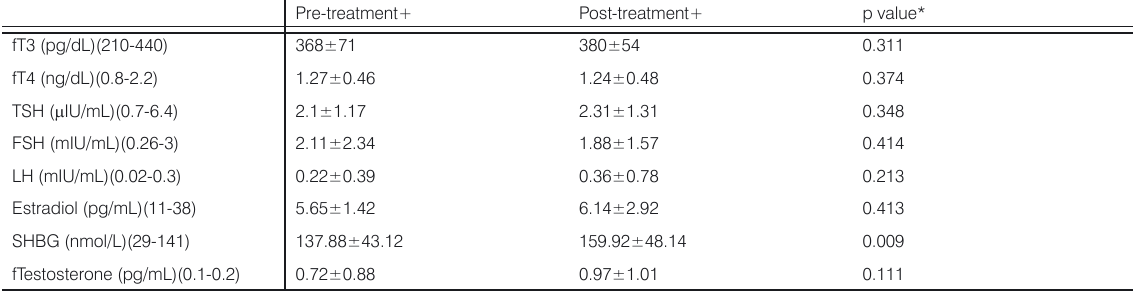
Table 2. Comparison of pre-treatment and 6 months post-treatment thyroid and sex hormone levels.